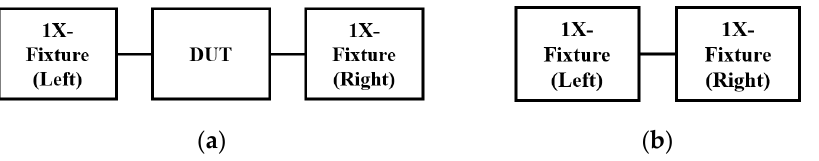
Figure 18. Design topology of the 2X-Thru SFD method: ( a ) whole structure consisting of the DUT and symmetric input/output auxiliary structures, ( b ) 2X-Thru structure.